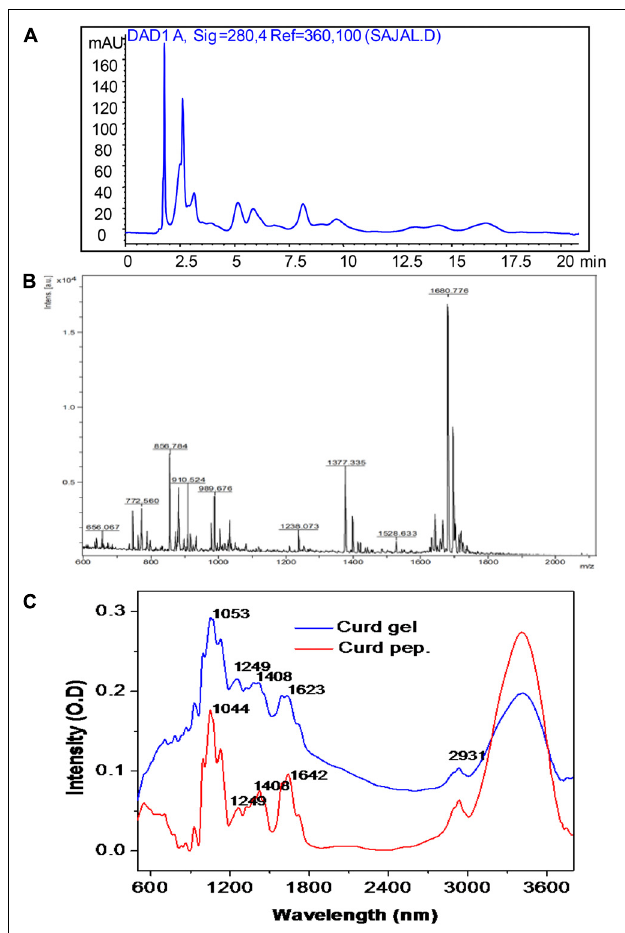
FIGURE 2 | High-performance liquid chromatographic profile of extracted curd peptide (A) ; matrix-assisted laser desorption/ionization time of flight (MALDI-TOF) mass spectrometric profile of extracted curd peptide (B) ; Fourier transform infrared (FTIR) spectroscopic overlay profile of extracted peptide pool (red) and prepared hydrogel (blue) (C) .